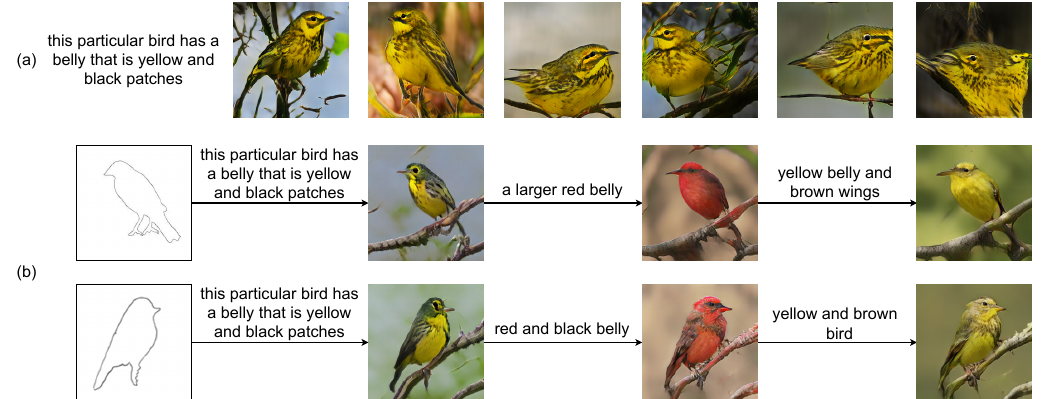
Figure 1. ( a ) The synthesized results of AttnGAN [5]. Given the input text description, AttnGAN synthesizes multiple image results with different qualities. ( b ) The upper contour was obtained by processing the dataset image, and the lower contour was obtained by drawing manually. Based on text and contour information, our method can synthesize the corresponding image. Then, the synthesized image content can be continuously modified based on the new